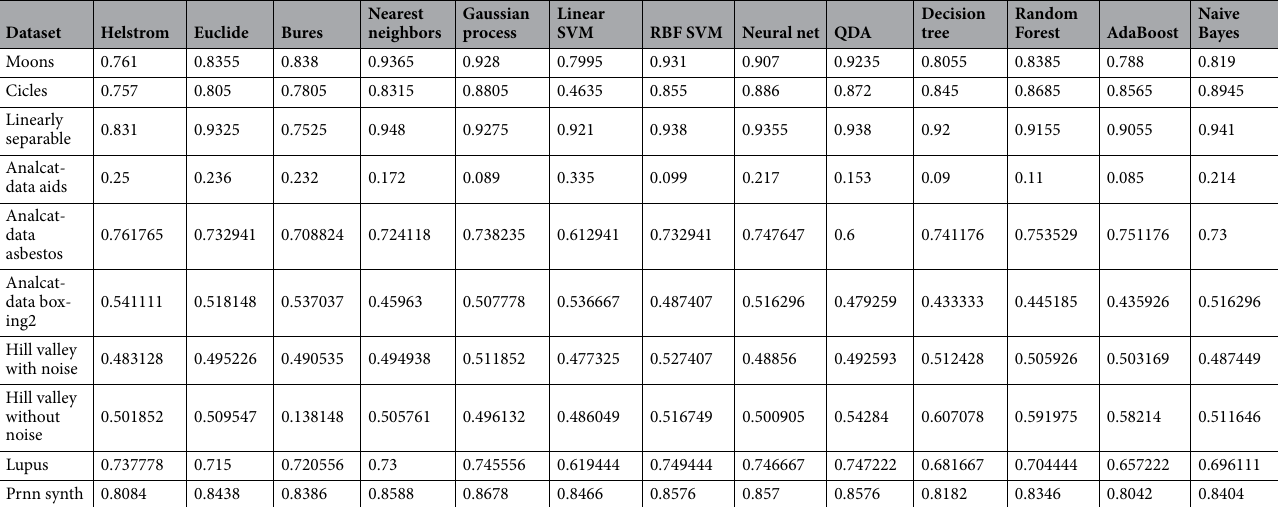
Table 3. Average accuracy with 2 features mapped into high-dimensional feature space ℝ 5 .